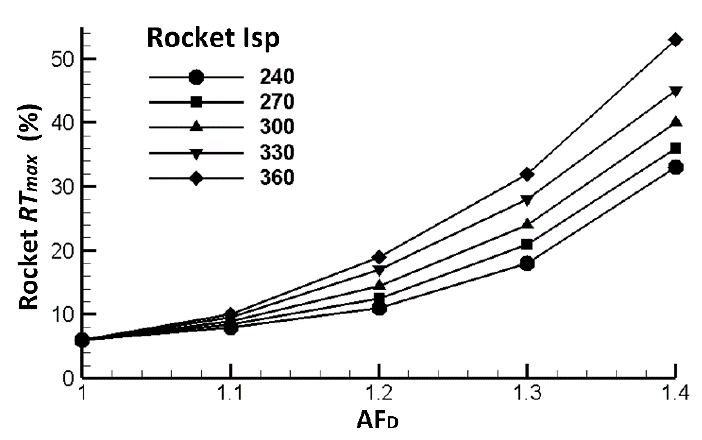
Figure 12. Optimal rocket RT max under various AF D and rocket Isp.